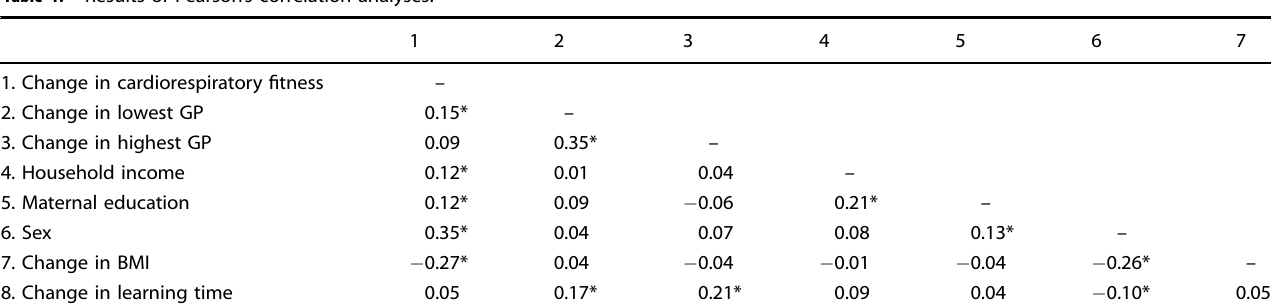
Table 1. Results of Pearson ’ s correlation analyses.